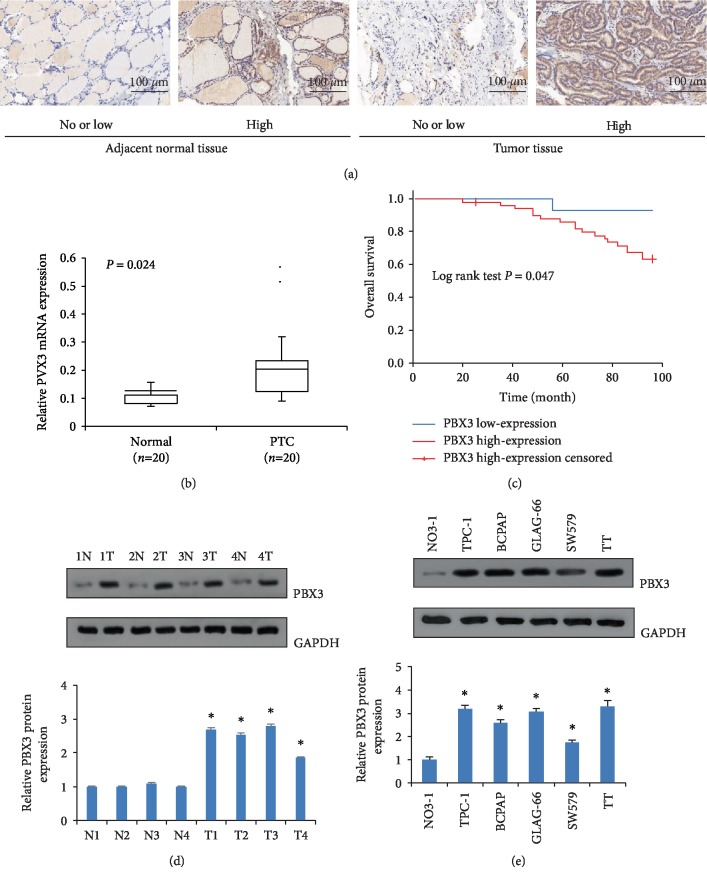
PBX3 is up-regulated in papillary thyroid carcinoma (PTC) and cancer cells. (a) Representative immunohistochemical staining of PBX3 protein in PTC tissues and adjacent normal tissues. (b) Expressions of PBX3 mRNA were significantly up-regulated in PTC (n = 20) compared with adjacent normal tissues (n = 20). (c) Patients with high PBX3 expression showed poor overall survival. (d) Expression of PBX3 protein in 4 representative paired samples of PTC tissues and adjacent normal tissues. (e) Up-regulation of PBX3 protein expression in PTC cells. ∗P0.05 versus normal control.